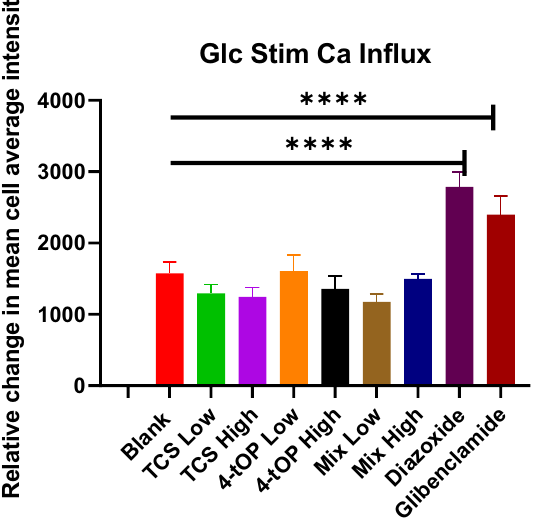
Figure 12. Effect of the test substances on glucose stimulated intracellular calcium influx. Diazoxide and Glibenclamide as positive controls. p values **** = 0.0001, n =